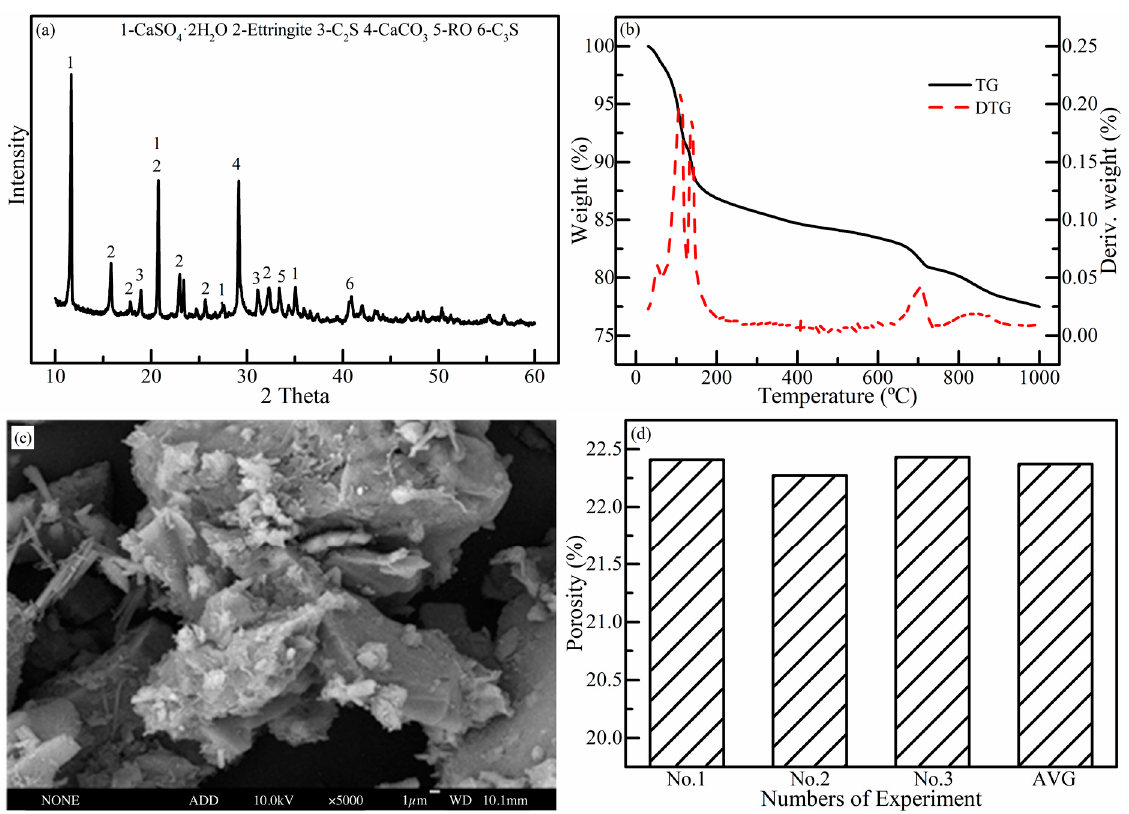
Figure 15. ( a ) XRD pa tt ern and ( b ) TG/DTG diagram of DG32-SSB-CP; ( c ) SEM micrograph and ( d ) MIP test results of DG32-SSB-CPB. All results are under 28 days of curing.